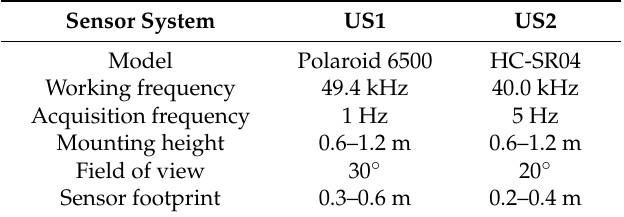
Table 3. Technical specifications of crop canopy ultrasonic sensors evaluated in cotton